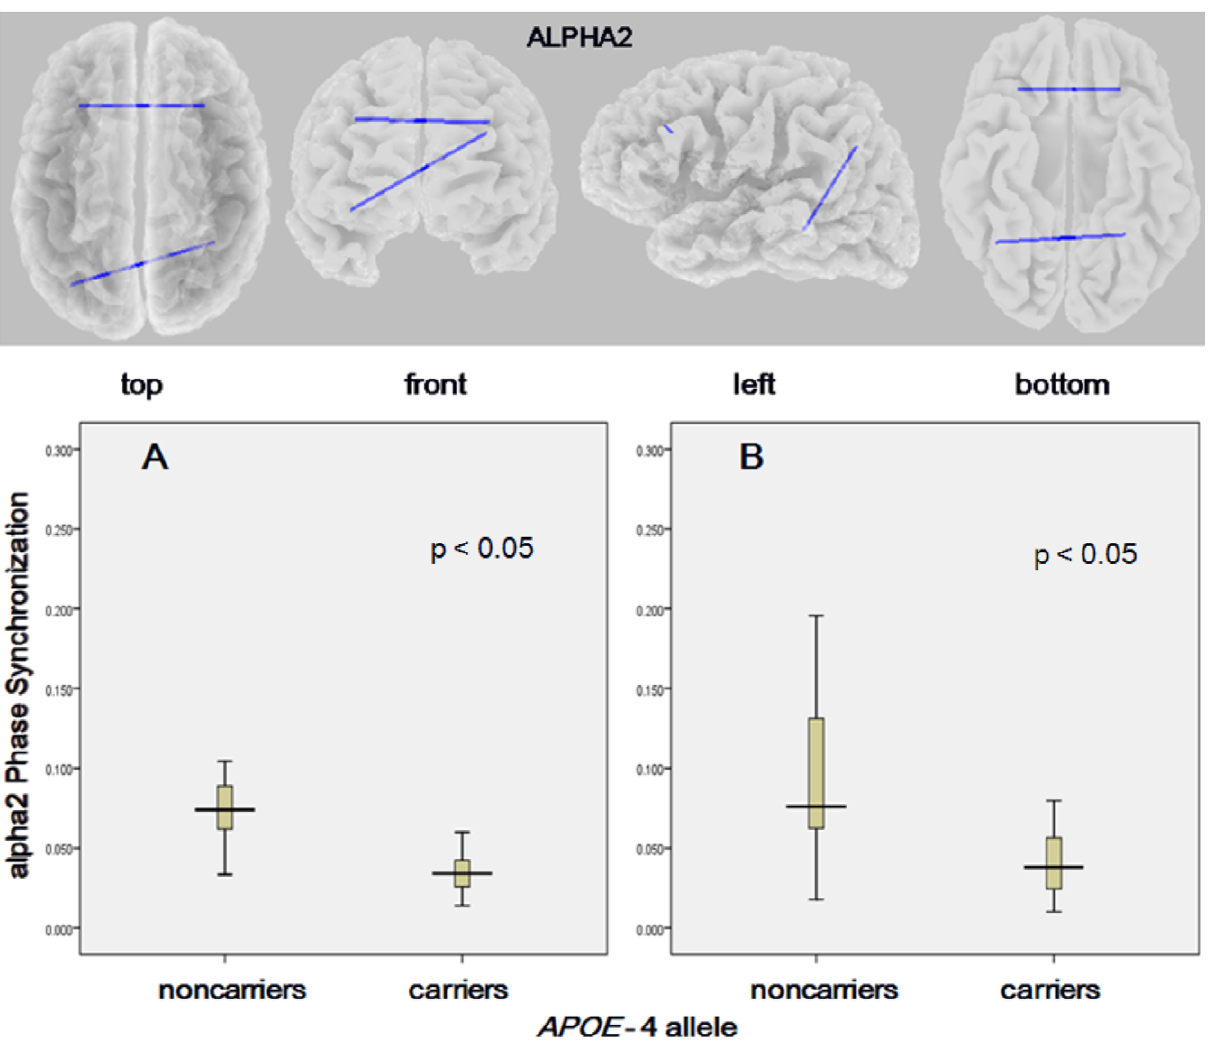
Figure 5. eLORETA wire diagram (top) and boxplots (bottom) of cortical areas with significantly decreased alpha2 lagged phase synchronization (blue wires) in APOE -4 carriers vs. noncarriers among patients with Alzheimer’s disease (threshold: t = 2 3.98; p , 0.05, corrected). The significant connectivity wires are displayed on a transparent fiducial cortical surface. The points to which the lines are connected represent the center of the ROIs. The boxes represent interquartile ranges of lagged phase synchronization between A) frontal areas and B) parieto-temporal areas. The lines across the boxes indicate medians, and the whiskers show the highest and lowest values, excluding outliers.